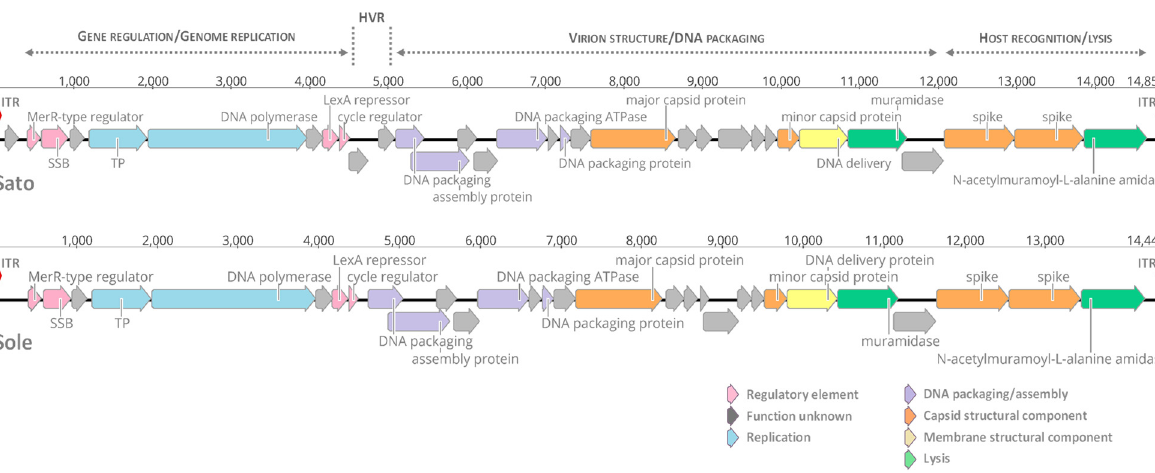
Figure 1. Genetic maps of tectiviruses Sato ( top ) and Sole ( bottom ). Predicted genes and their direction of transcription are represented as block arrows. Inverted terminal repeats (ITR) are shown as red arrows at both ends of the genomes. The color key at the bottom-right indicates known and postulated gene functions [4,10,22,23,44–46]. Three genetic modules based of functional grouping, together with the highly variable region (HVR), are indicated above the genomes. The rulers represent base pairs in the phage genomes. MerR-type, a putative transcriptional regulator; SSB, ssDNA binding protein; TP, terminal protein.